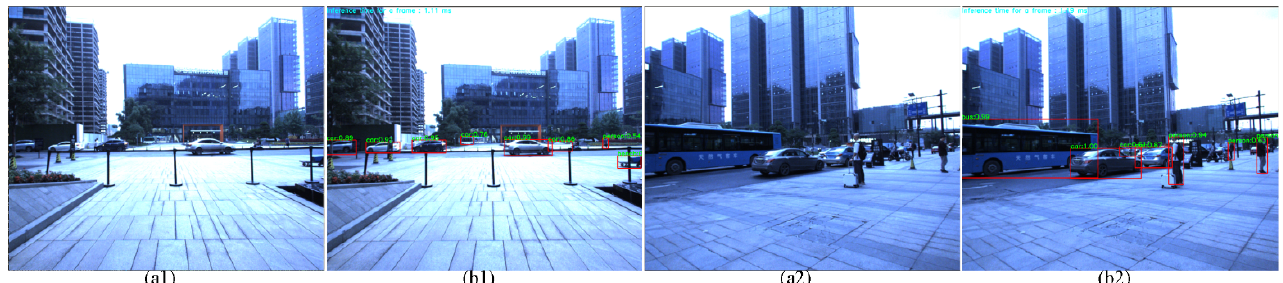
Figure 3. The object detection and recognition based on the color images: ( a1 , a2 ) the color images with zero-degree polarization; ( b1 , b2 ) the object detection and recognition using the YOLO V4 network, the detection and recognition results are labelled using the red bounding box. The class name and the confidence are put on the upper left corner of the bounding